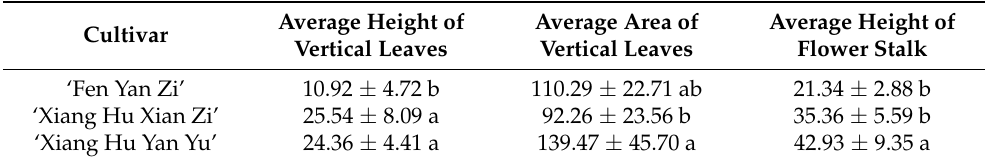
Table 6. Comparison of leaf characters and flower stalk height among 3